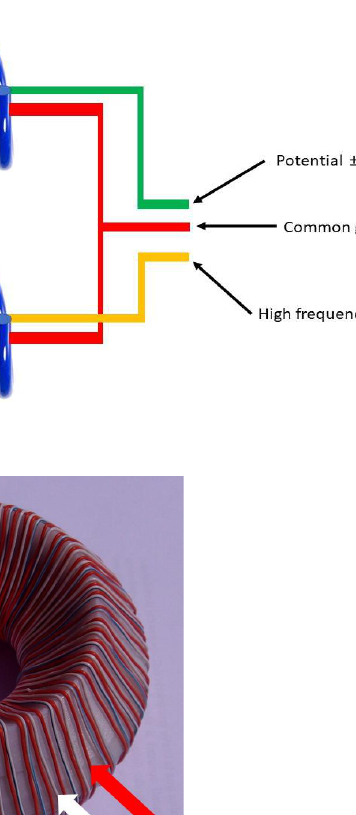
Figure 4. Printed support of the ring (picture a ), relative to the bottom part. The internal copper loop, to be connected to ground through a small radial conductor, is visible. In ( b ), we can see the two parts assembled. The maximum diameter of the device is approximately 10.5 cm and the proportions are those shown in Figure 2.